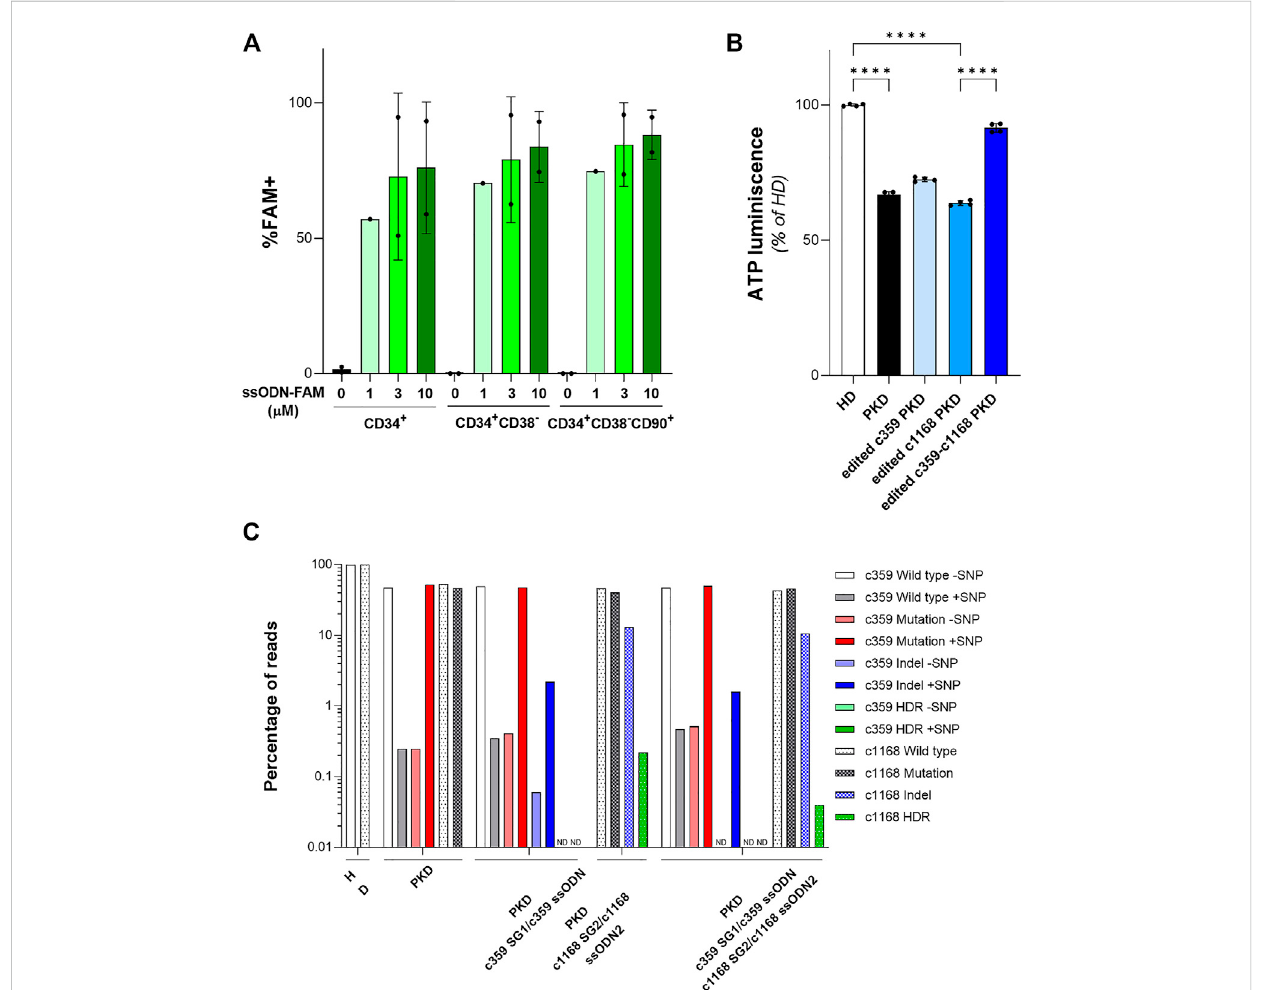
FIGURE 4 Gene editing in hematopoietic stem and progenitor cells (HSPCs) with gRNA and ssODN targeting PKD-causing mutations. (A) Percentage of FAM + HSPCs after being nucleofected with different concentrations of ssODN-FAM. The immunophenotype of the HSPCs was analyzed. Data are obtained from 2 independent experiments. (B) ATP quanti fi cation of erythroid cells derived from PKD-HSPCs of a single patient differentiated in vitro after gene editing. Data are obtained from 3 technical replicates. (C) Frequency of the different reads identi fi ed by Next Generation Sequencing in erythroid cellsderivedfromPKD-HSPCsofasinglepatientdifferentiatedinvitroaftergeneeditingwiththespeci fi cgeneeditingtoolsforc.359C > Tandc.1168G > A mutations. Data are presented by mean ± SD. Signi fi cance was analyzed by ANOVA with Turkey ’ s multiple comparison test. The signi fi cance was represented by p -values: **** p <